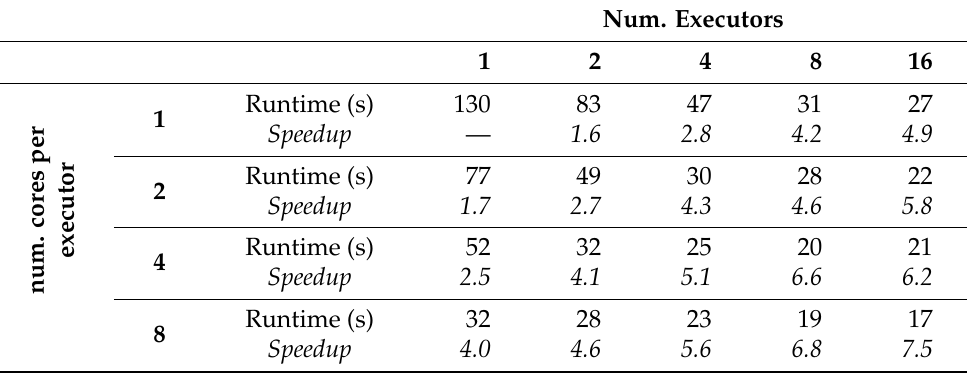
Table 1. Efficiency of the lower level of parallelization—Small Dataset.